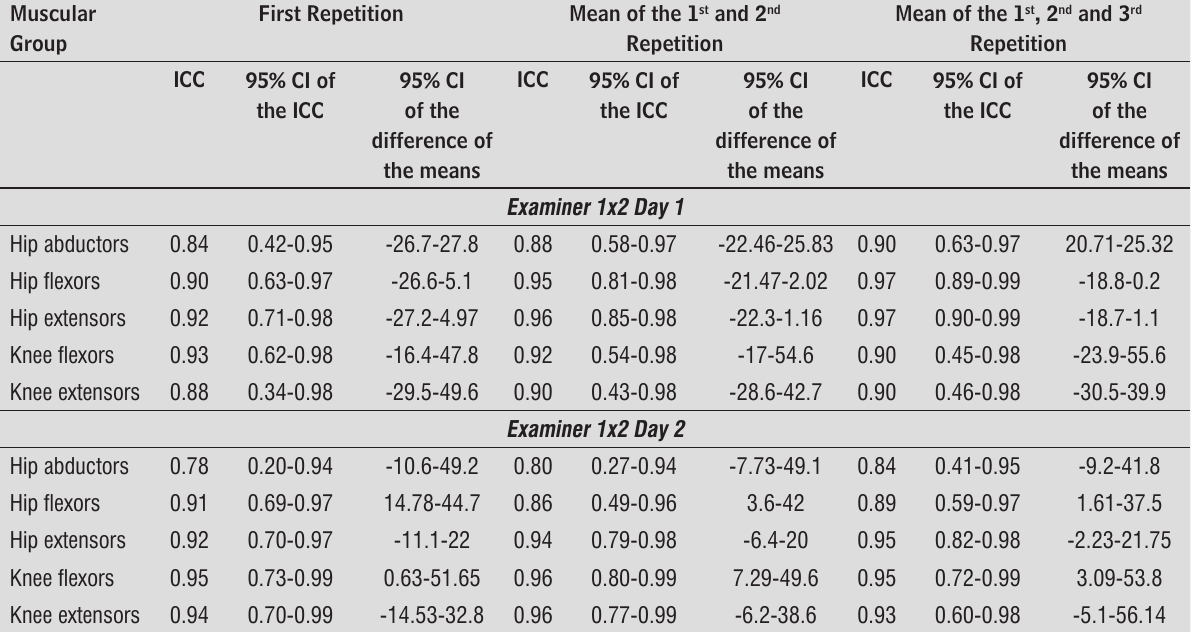
Table 5 - Intra-Class Correlation Coefficient (ICC) values for the inter-examiner reliability test using the AST to evaluate the strength of the hip abductor muscles; flexor and extensor muscles of the hip and knee, considering the repetitions in the two distinct sessions, including data from examiner 1 and